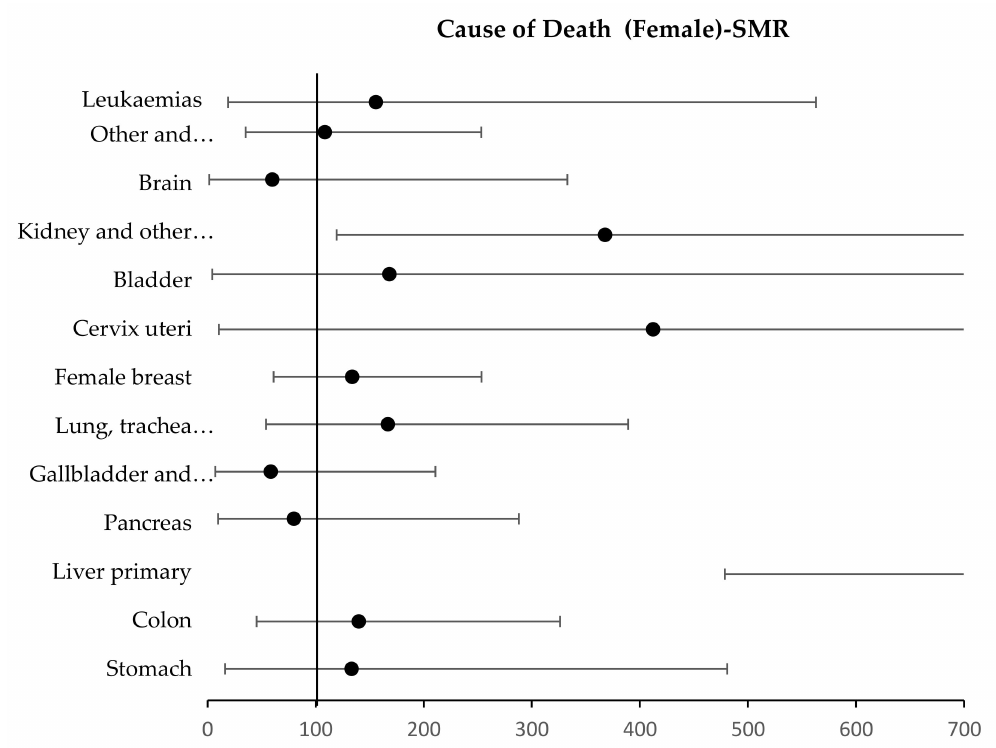
Figure 6. Forest plot of observed female deaths by cancer type (SMR). An SMR < 100 indicates fewer than expected deaths. An SMR = 100 indicates observed deaths equal expected deaths. An SMR > 100 indicates there were excess